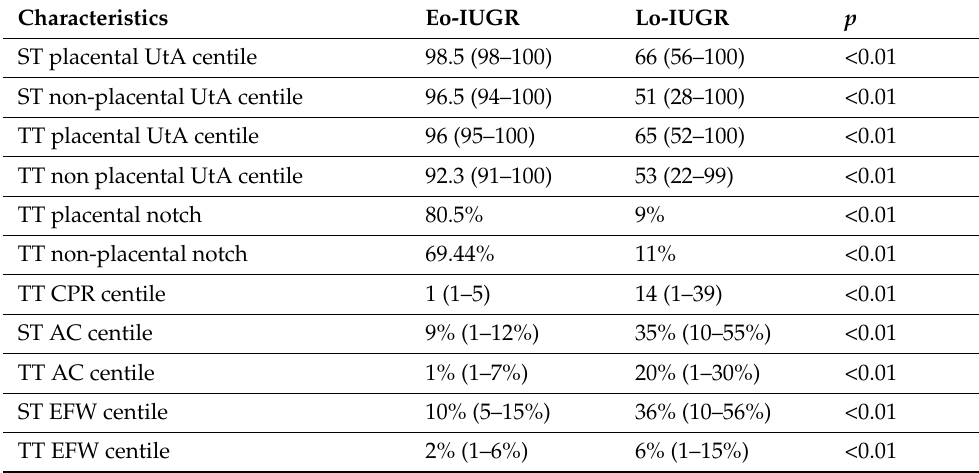
Table 2. Ultrasound features in pregnancies complicated with early- and late-onset